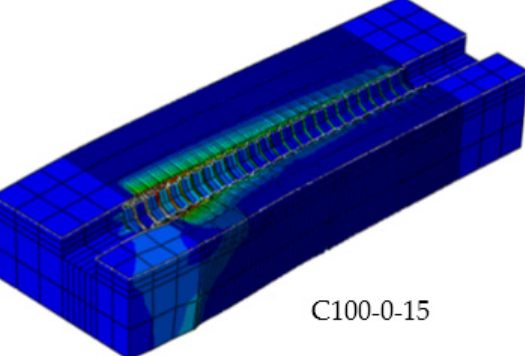
Figure 16. Von Mises stress distribution in concrete simulated by finite element method.